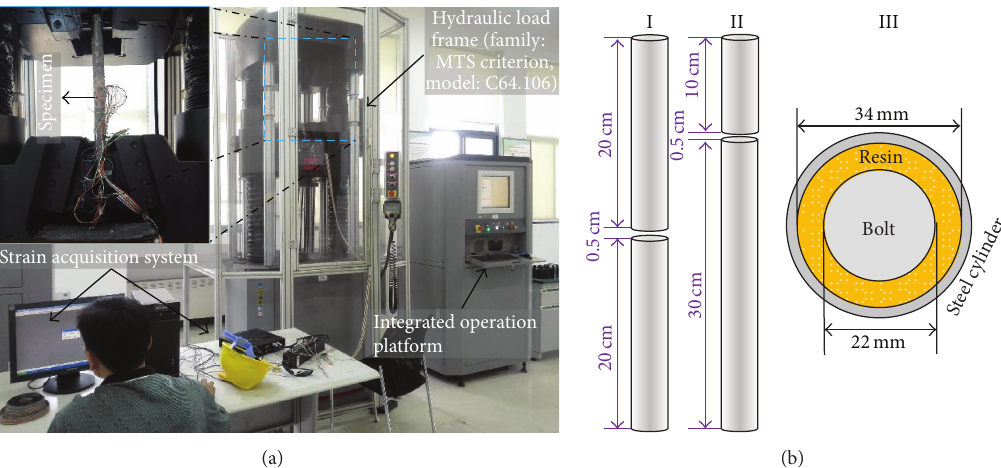
Figure 11: Experimental facilities and detailed parameters for the uniaxial bolt tension test. (a) Loading system and data acquisition facilities. (b) Detailed parameters for the steel cylinder and cross section of anchoring body; note that I represents separation occurring in the middle of the anchoring body, for which ten strain gauges were installed; II represents separation occurring at the free loading end, for which eleven strain gauges were installed; and III shows the cross-sectional dimensions of the